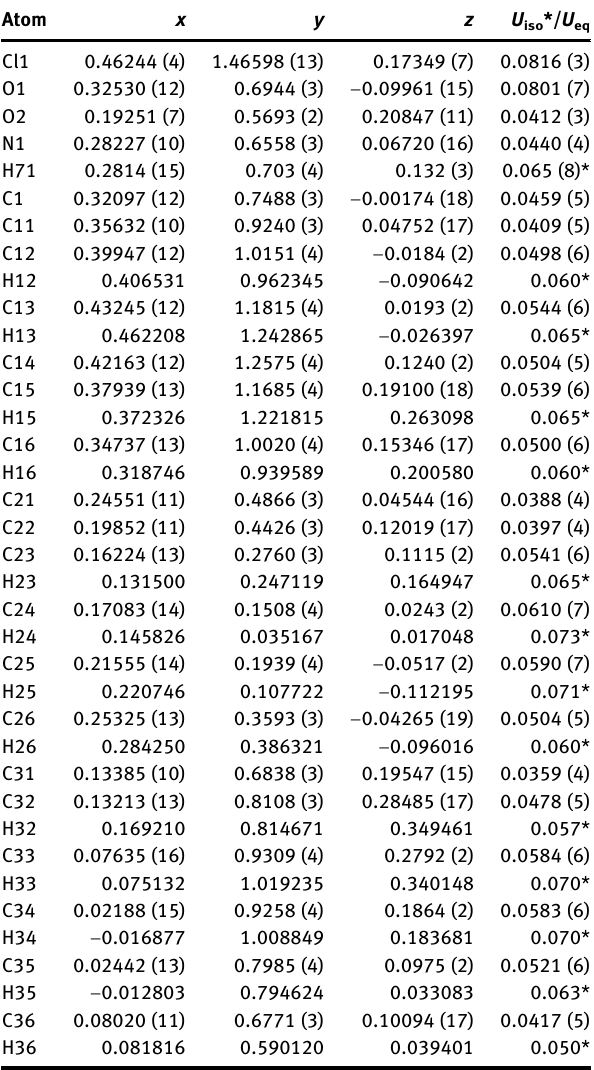
Table  : Fractional atomic coordinates and isotropic or equivalent isotropic displacement parameters (Å  ).